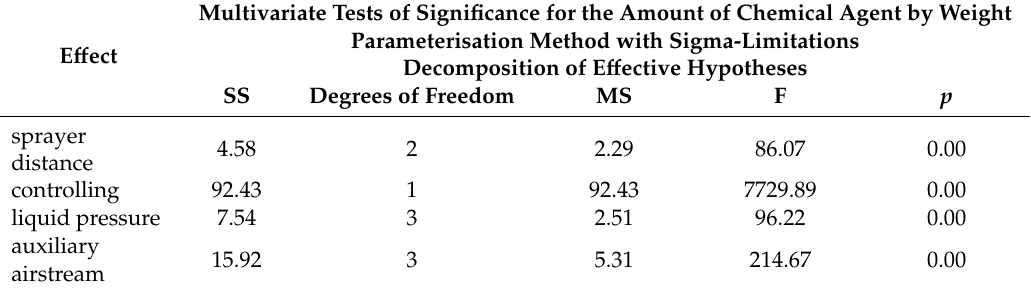
Table 2. The results of multivariate analysis of variance (MANOVA) of the adopted parameters vs the amount of the agent applied to the surface of seed potatoes. Multivariate Tests of Significance for the Amount of Chemical Agent by E ff ect